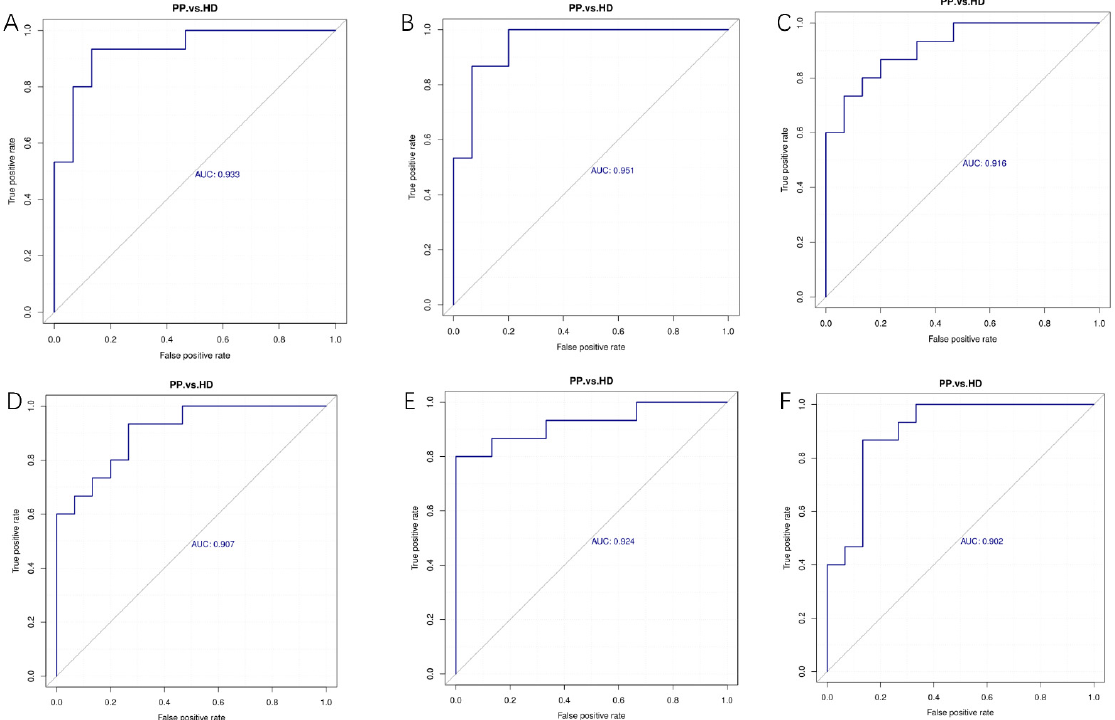
Figure 6. The receiver operating characteristic (ROC) curves analysis of differential metabolites. ( A – F ). AUC values of Tributyl citrate ( A ), Kynurenic acid ( B ), Acetylcysteine ( C ) and Isoquinoline ( D ) in the positive mode, and Phe-Pro ( E ), D-Glucose 6-phosphate ( F ) in the negative mode were all more than 0.9.